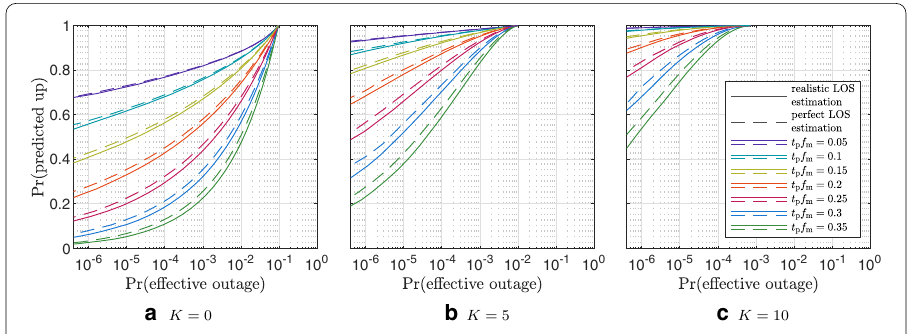
Fig. 15 Analysis of the outage prediction performance. 20 dB SNR, F = 10dB , (cid:31) tf m = 0.05 , M = 25 and N = 128